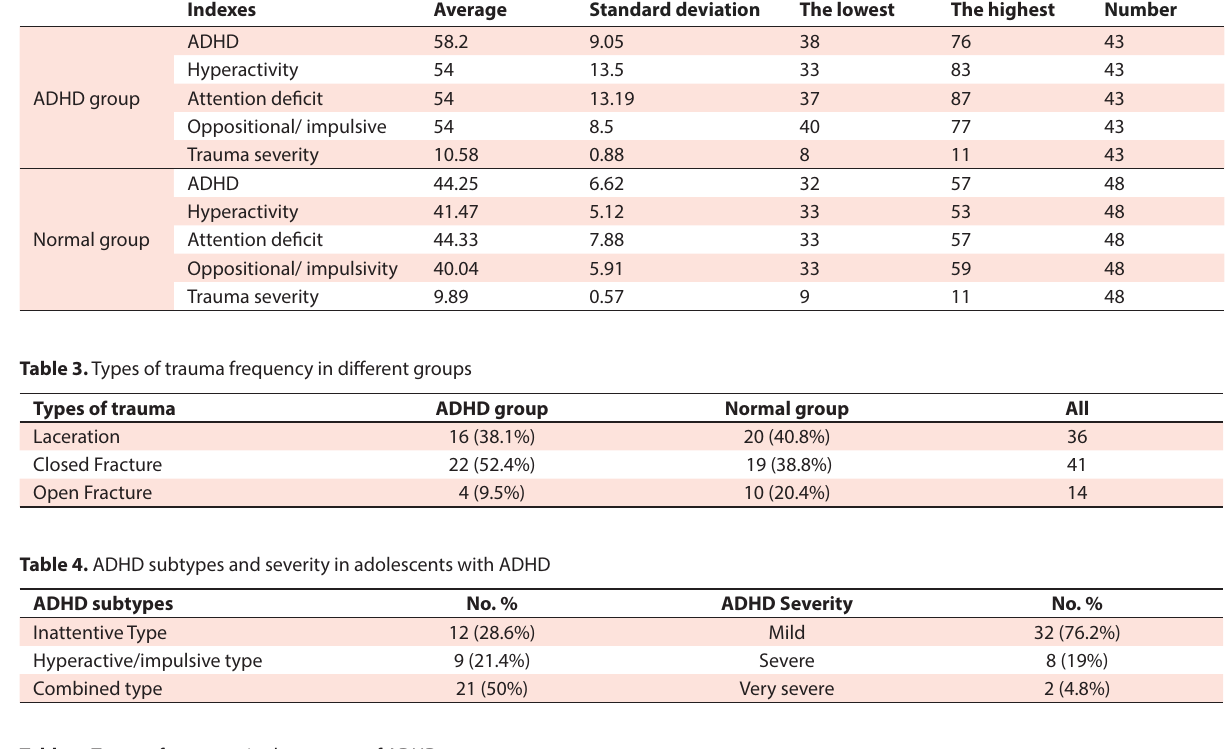
Table 5. Trauma frequency in three types of ADHD Trauma